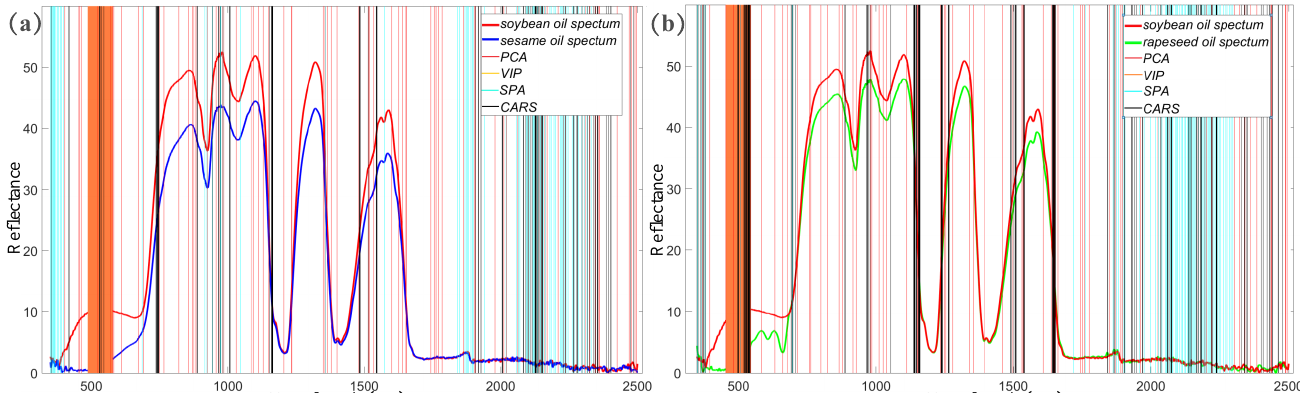
Figure 6. Effective wavelengths selected by PCA, SPA, VIP, and CARS for the best prediction model (PLSR + MSC + CARS). ( a ) Effective wavelengths in sesame oil adulterated with soybean, ( b ) Effective wavelengths in rapeseed oil adulterated with soybean. The red vertical line corresponds to the effective wavelengths selected by SPA; the green vertical line corresponds to the effective wavelengths selected by VIP; and the black vertical line corresponds to the effective wavelengths selected by PCA. The spectrum of rapeseed oil was chosen as the background